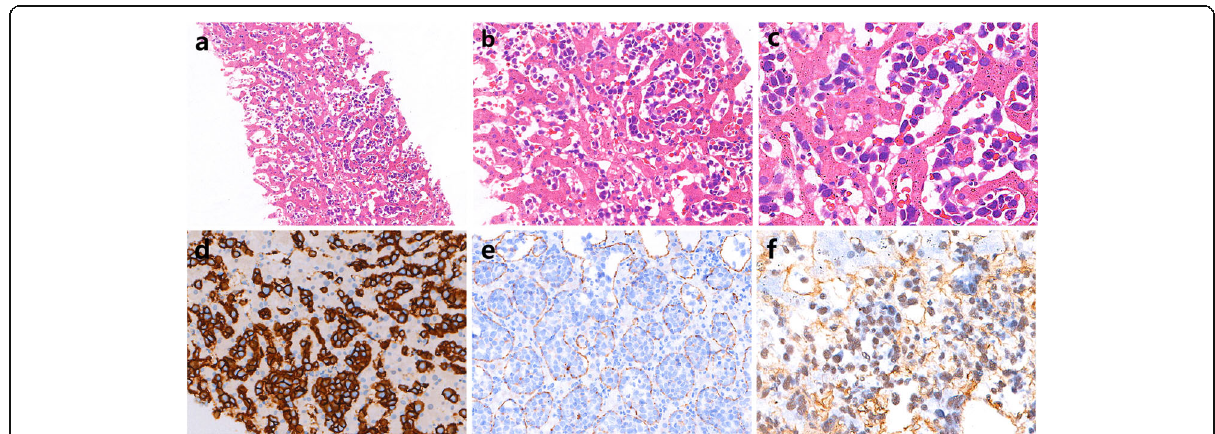
Fig. 2 a & b Histopathology analysis showed the hepatic sinusoids were markedly expanded by the selective proliferation of atypical lymphocytes ( a: magnification × 100 and b: magnification × 200). c. The neoplastic cells were large in size with round to oval-shaped nuclei and scant cytoplasm (magnification × 400). d. The tumor cells were positive for CD20 (magnification × 200). e. CD31 immunohistochemical staining